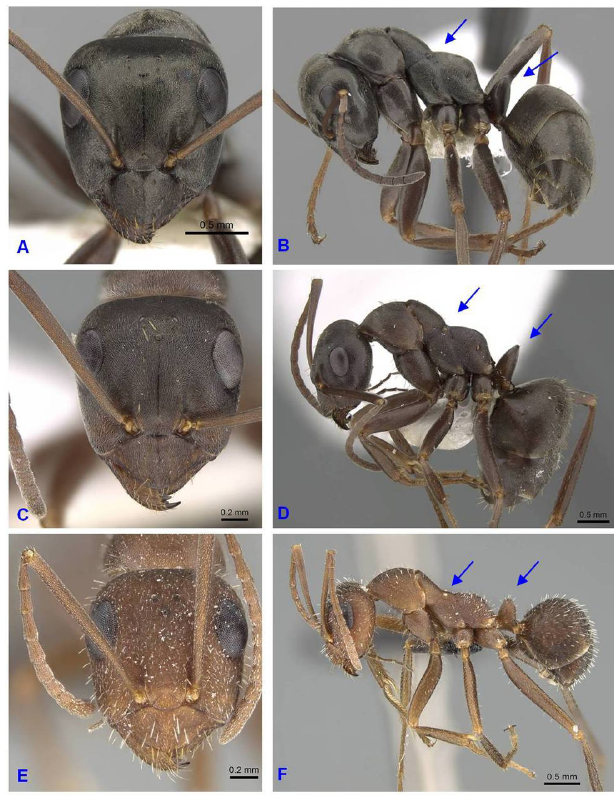
Fig 7 . Workers of Formica fusca (A, B) [CASENT0280385], Formica gerardi (C, D) [XE00205-1] and Iberoformica subrufa (E, F) [KG030006-2]. Images from www.antweb.org